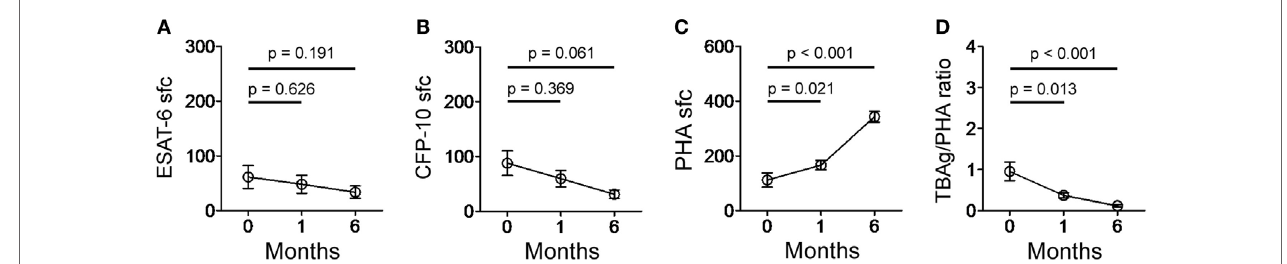
FigUre 6 | T-SPOT results and the TBAg/PHA ratio in EPTB patients after anti-TB treatment. Dot plots showing (a) ESAT-6 sfc, (B) CFP-10 sfc, (c) PHA sfc, and (D) the TBAg/PHA ratio in EPTB patients ( n = 13) before and after 1 and 6 months of anti-TB treatment. Abbreviations: EPTB, extrapulmonary tuberculosis; ESAT-6, early secreted antigenic target 6; CFP-10, culture filtrate protein 10; PHA, phytohemagglutinin; TBAg, TB-specific antigen; sfc, spot-forming